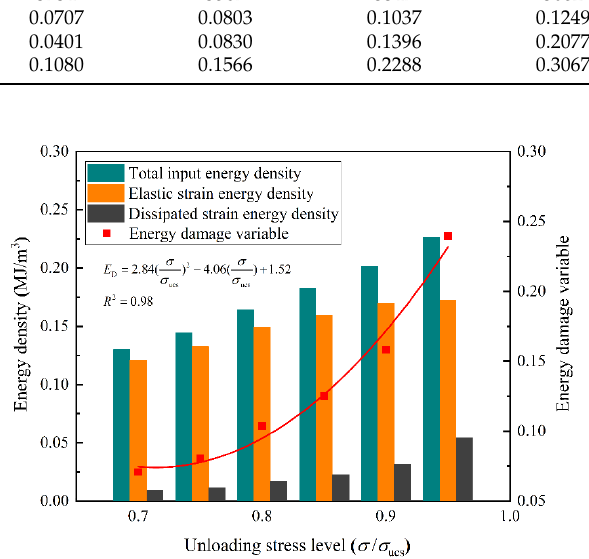
Figure 7. Variation in the energy densities and energy damage variable.